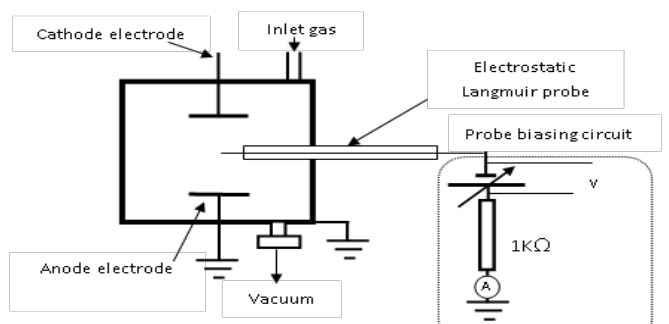
Fig. 1: Schematic diagram of the DC glow discharge sputtering chamber and Langmuir probe circuit.